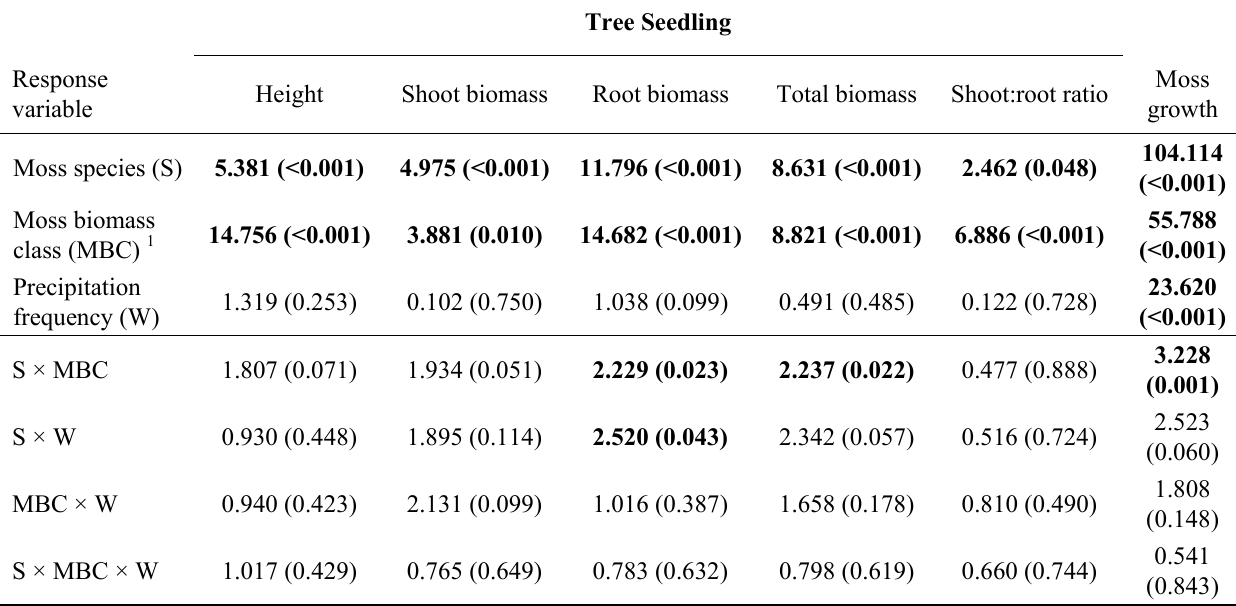
Table 1. The effect of four moss species, moss biomass class and precipitation frequency and their interaction effects on Pinus sylvestris seedling and moss growth; values represent the results ( F -value) of a three-way ANOVA with replicates organized into blocks (serving as a random factor) and significant levels ( p -values) in parentheses; significant effects are shown in bold ( p < 0.05).